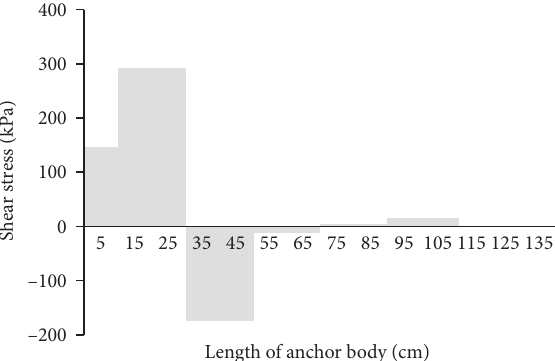
Figure 15: Shear stress distribution of anchor